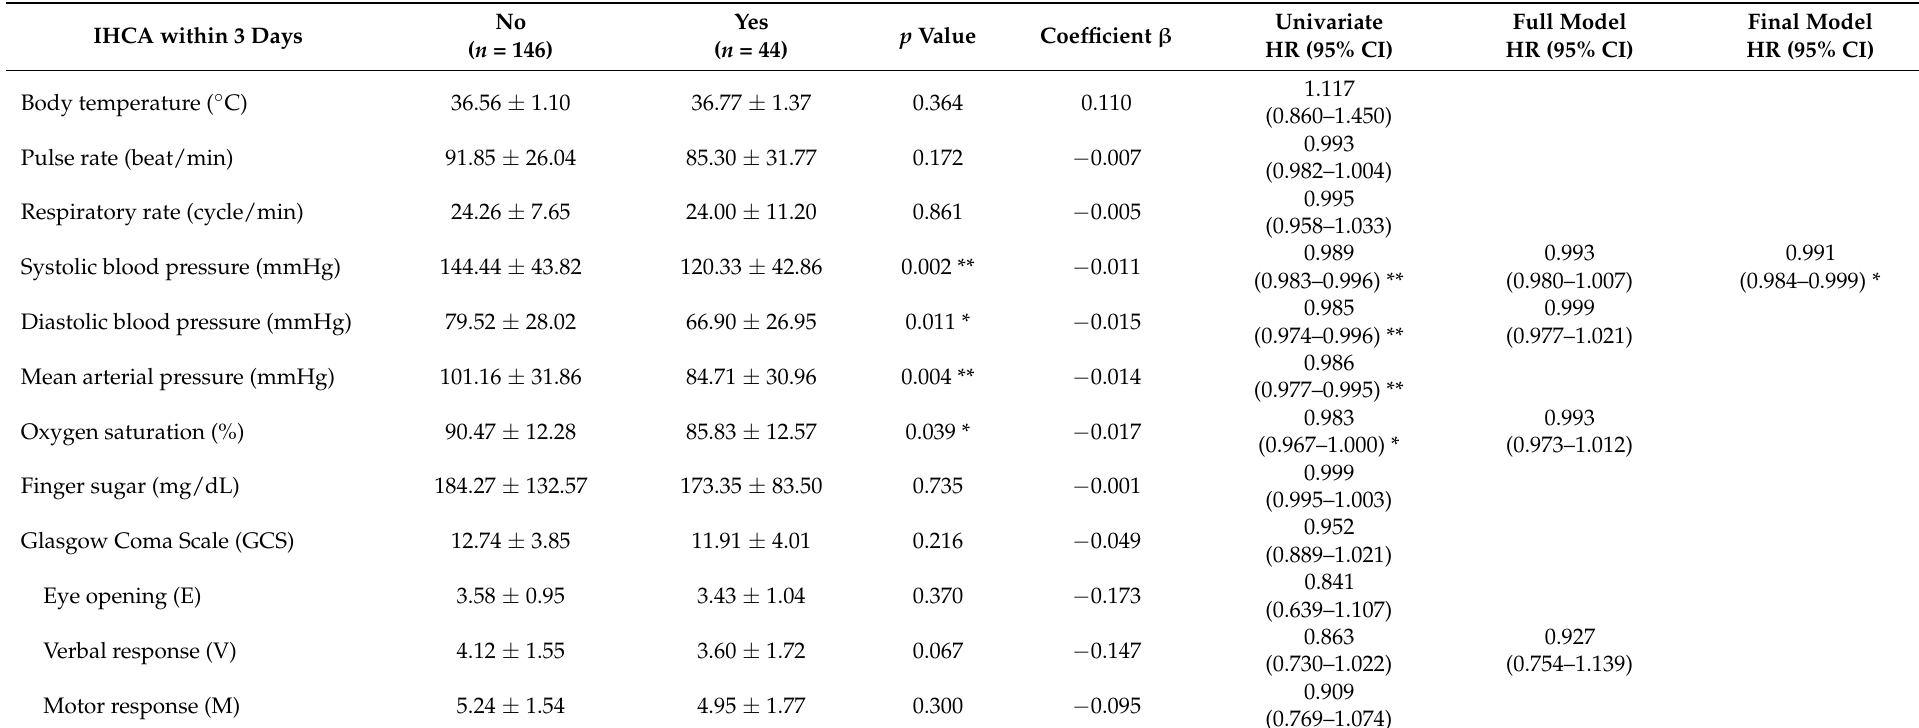
Table 2. The characteristics of the triage domain for the in-hospital cardiac arrest (IHCA) risk with COX